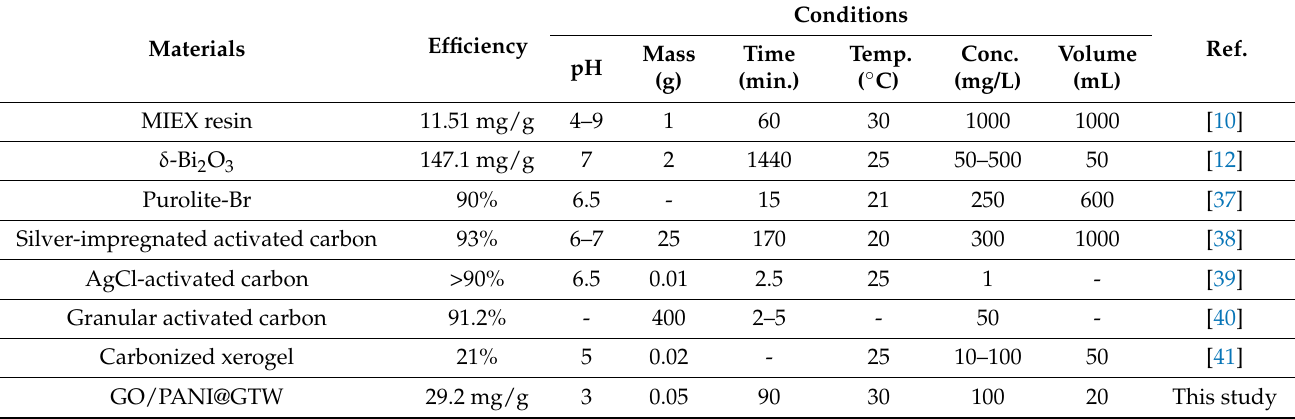
Table 3. Comparison of the adsorption capacities of various materials for Br − removal.